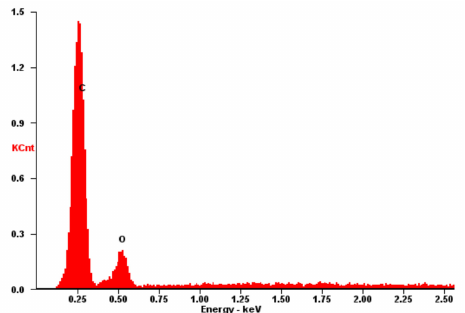
Figure 3. Typical EDS spectrum recorded for the surface of the reference sample textolite material. Only carbon and oxygen were present, which were derived from an organic epoxy resin. They represented 71.5% and 28.5% by weight,